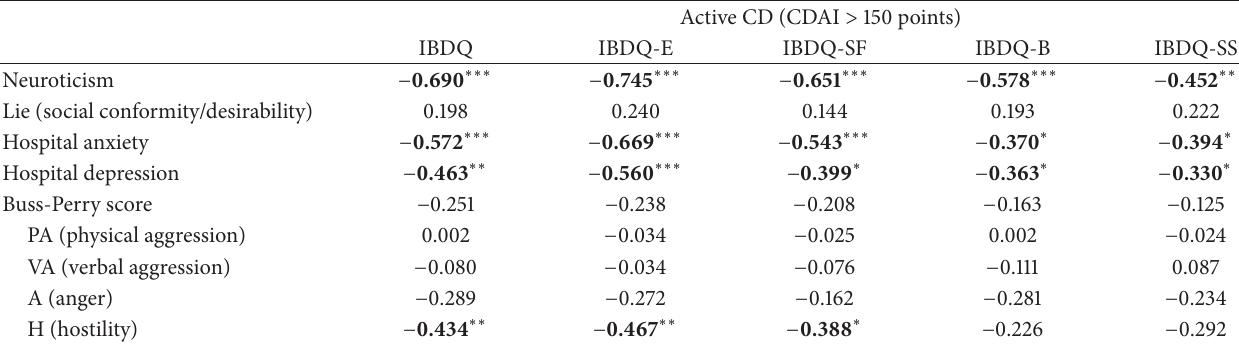
Table 5: Spearman correlation analysis ( P value) between different psychological variables and Inflammatory Bowel Disease Questionnaire and its subscales in patients with active Crohn’s disease (CDAI > 150